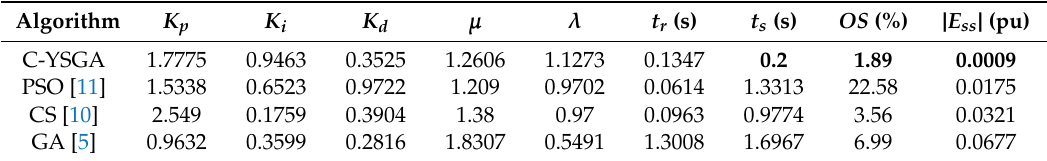
Table 8. Comparison of the transient response parameters.